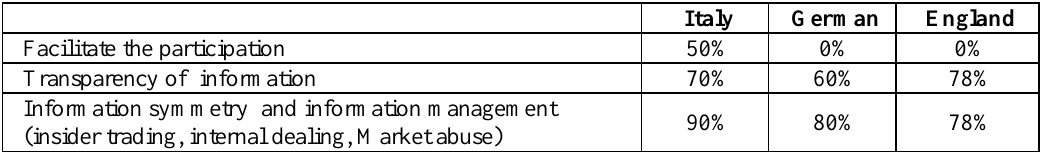
Table 4: Standard Behaviours in the Relations with the